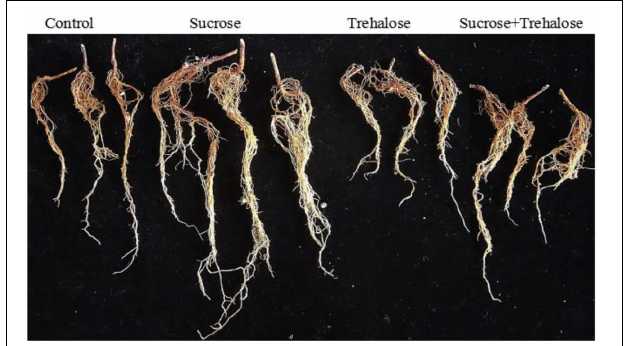
FIGURE 5 | Effects of different treatments on the root phenotype of peach